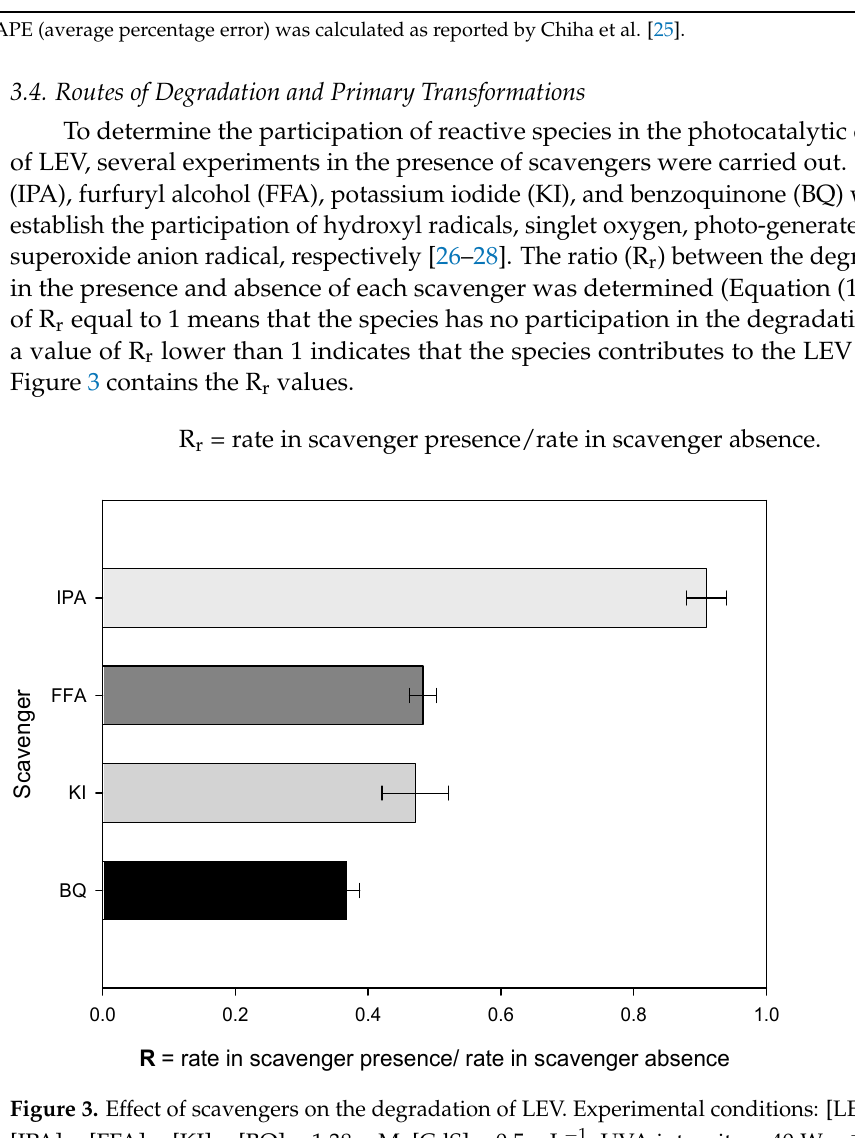
Figure 4. Schema of the primary transformations of LEV under photocatalysis using CdS. 3.5. Degradation of Levofloxacin in Complex Matrices The degradation efficiency of the photocatalytic processes is strongly dependent on both the pH and matrix components of water [9,29]. Hence, the photocatalytic elimination of the target pollutant at diverse pH values was assessed. Furthermore, the degradation in matrices more complex than distilled water, i.e., synthetic fresh urine (urine) and sim- ulated hospital wastewater (HWW), which are primary sources of pollution by pharma- ceuticals, was considered (see matrix composition in Tables 2 and 3). Figure 5 compares